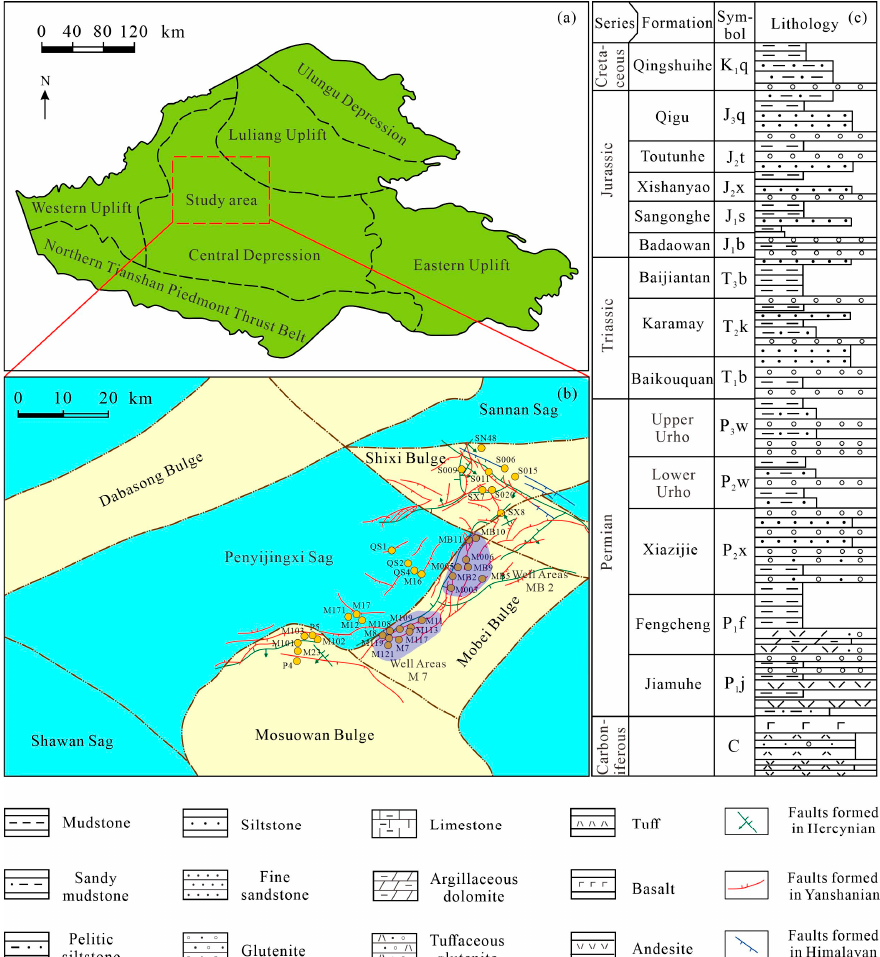
Figure 1. Geological overview of the eastern belt around the Penyijingxi sag in the Junggar Basin, NW China (modified from refs. [32,37]). ( a ) Division of tectonic units in the Junggar Basin, ( b ) geological overview of the eastern belt around Penyijingxi sag, and ( c ) stratigraphic column of the Penyijingxi sag.